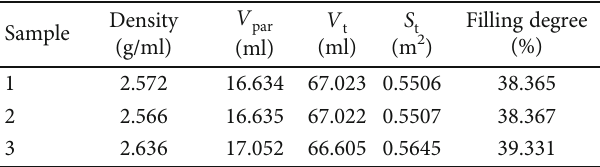
Table 1: Densities, volumes, and fi lling degrees of three shale samples in